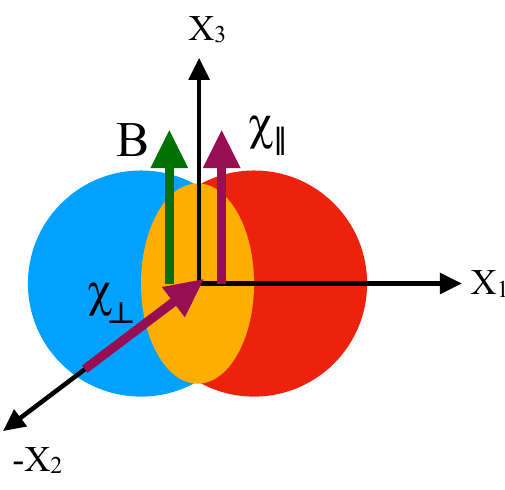
Figure 1 . Schematic picture of an off-central heavy-ion collision. The beam direction is denoted by x . Red and blue circles represent the colliding gold/lead nuclei moving in the + x 2 directions respectively. They produce an almond shaped plasma here shown in orange. The amount of anisotropy in the stress-energy tensor is represented by the χ vectors, drawn in purple. χ the amount of anisotropy in the interaction plane ( x collisions, distinguishes plasma pressure in the x interaction plane. A magnetic field in the x off-central collisions) mostly by the nucleons that do not participate in the formation of the plasma but fly away (here represented by the non-overlapping portions of the blue and red